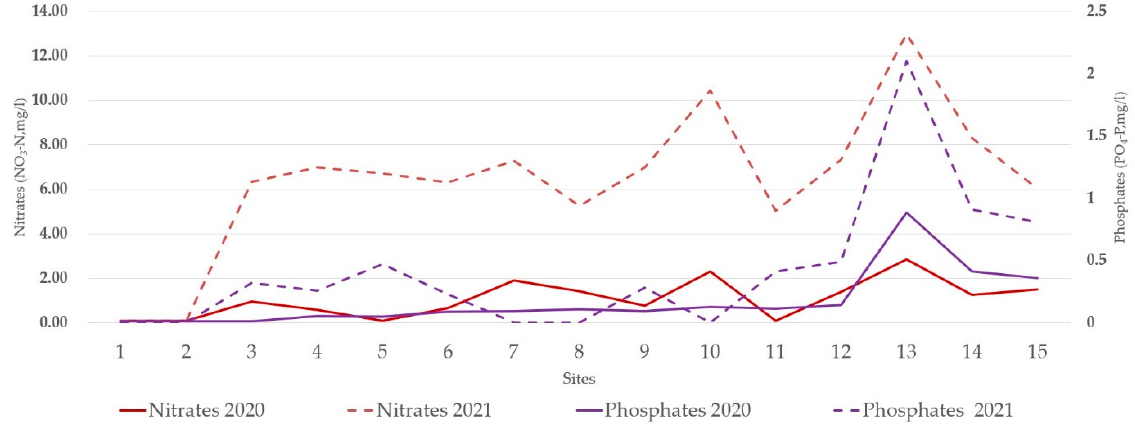
Figure 3. Dynamics of the values of the nutrients at the studied sites in 2020 and 2021.